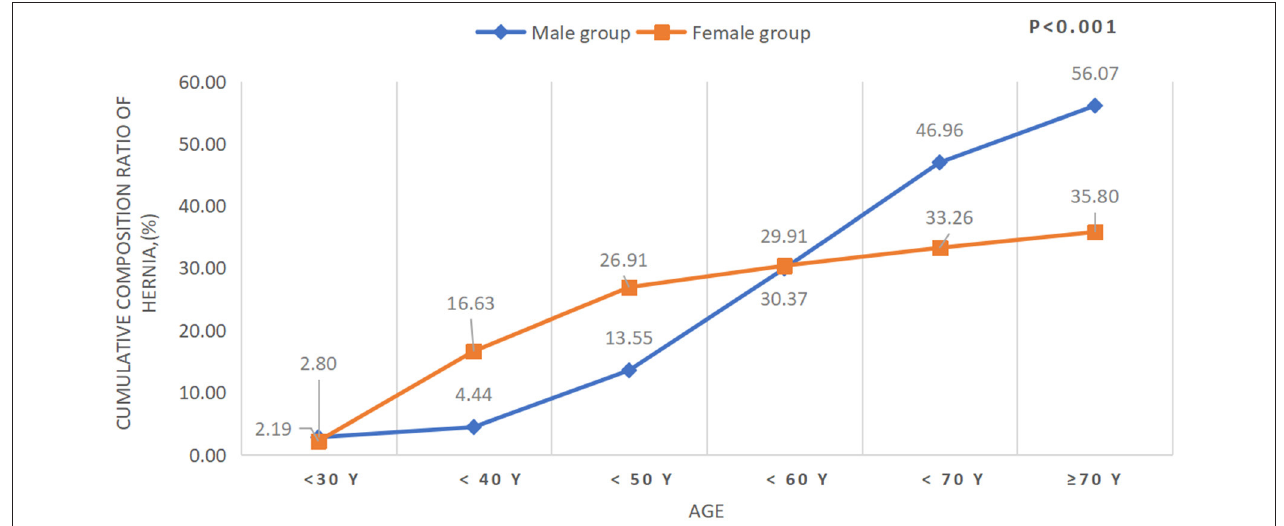
FIGURE 2 | Cumulative composition ratio of hernia.